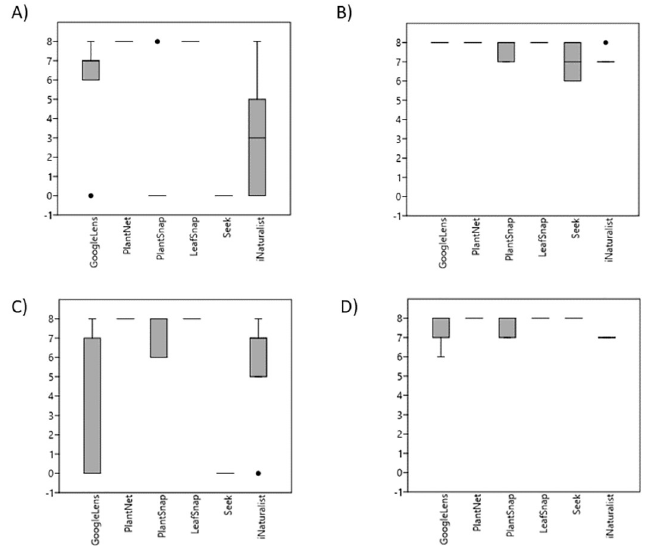
Fig 2. Leaf and flower scores for the toxic plants used in the current study (A) Foxglove ( Digitalis purpurea ) leaf raw data (B) Foxglove ( Digitalis purpurea ) flower raw data (C) Enchanter’s nightshade ( Circaea lutetiana ) leaf raw data (D) Enchanter’s nightshade ( Circaea lutetiana ) flower raw data. The line bisecting each box represents the median sore achieved by that